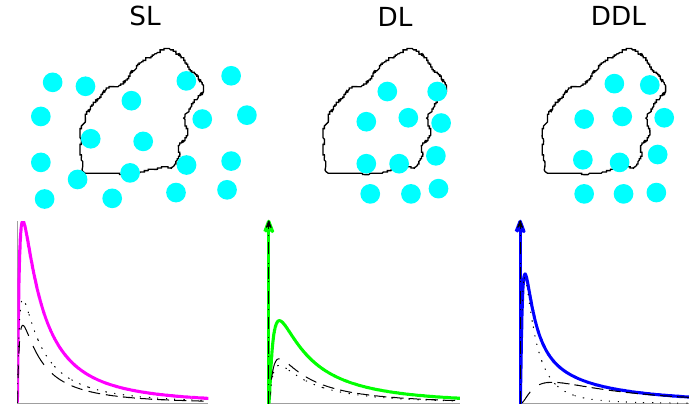
Figure 1. A schematic of the single lognormal (SL), delta-lognormal (DL), and delta-double-lognormal (DDL) hydrometeor PDF shapes. The SL PDF shape is precipitating over the entire subgrid domain, whereas the DL and DDL shapes are not. In all three plots of the PDFs (where each PDF is a function of a hydrometeor species, such as r r ), the weighted PDF from each PDF component is shown (black dashes and black dots). The sum of the two are the SL (solid magenta), the DL (solid green), and the DDL (solid blue). The SL does not contain a delta at 0, and the mean and variance of each PDF component are the same. Each component of the DL has a delta at 0 (upward pointing black arrows on the y axis). The sum of the two component deltas forms the DL’s delta at 0 (upward pointing green arrow). The mean and variance of each DL PDF component are the same within precipitation. Each component of the DDL also has a delta at 0 (upward pointing black arrows). The sum of the two component deltas forms the DDL’s delta at 0 (upward pointing blue arrow). The mean and/or variance differ between DDL PDF components within